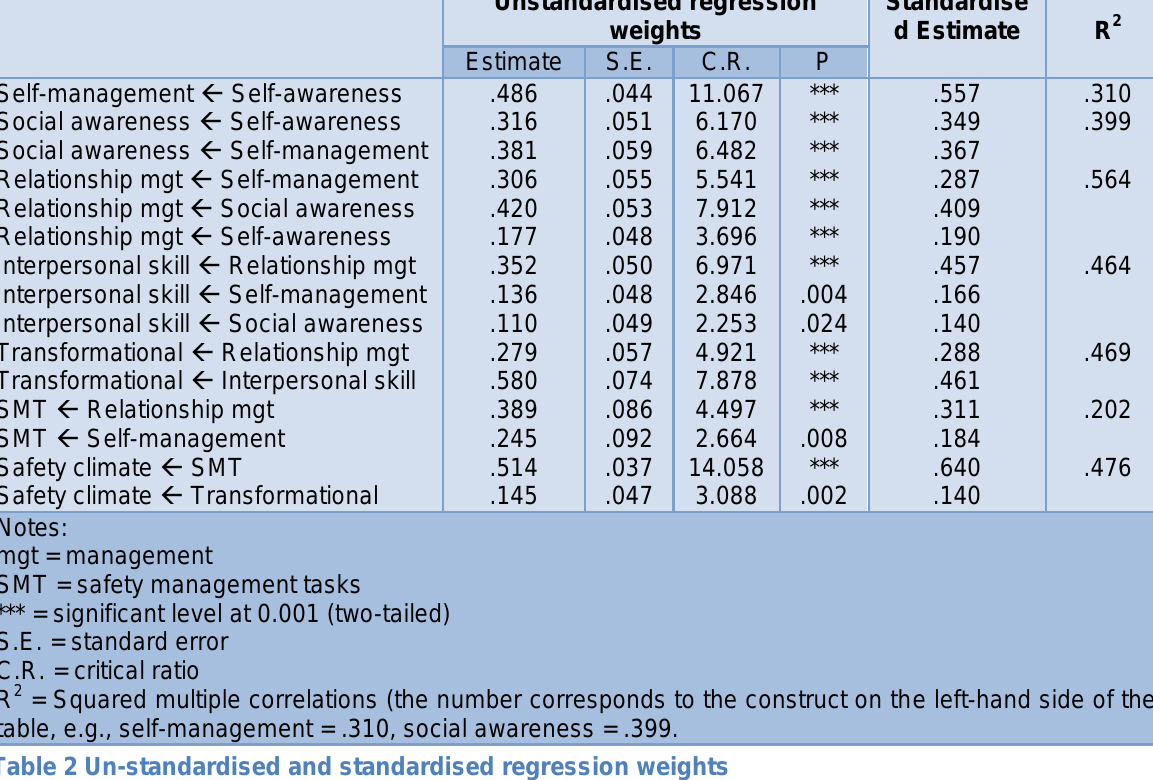
Standardise d Estimate R 2